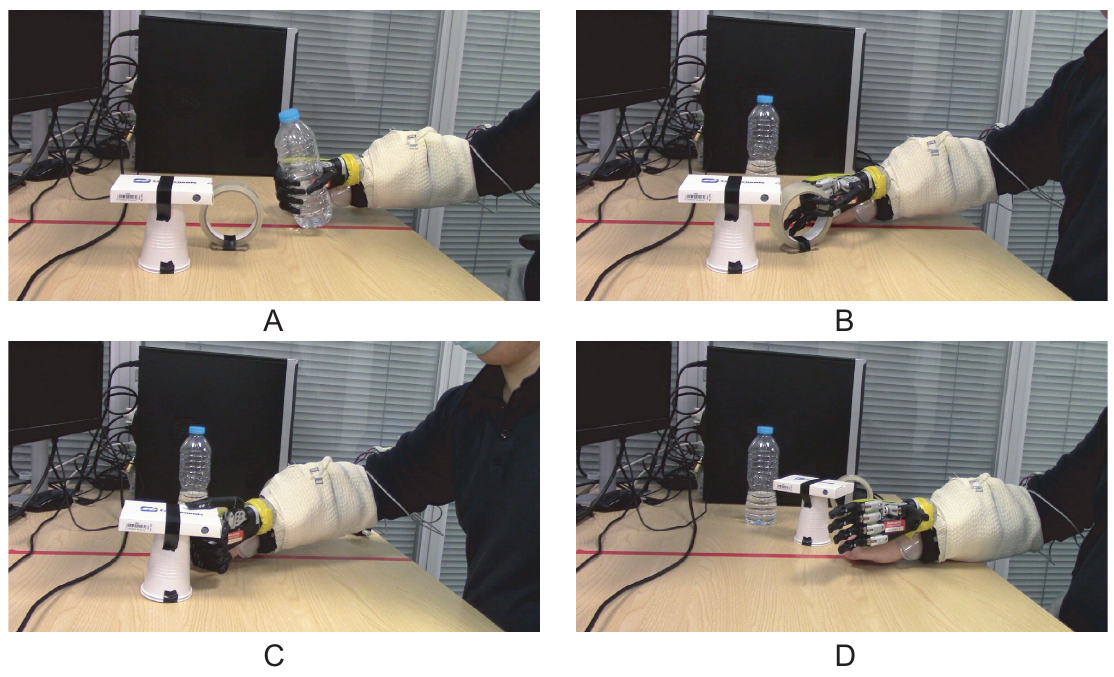
Figure 5. Real-time pick-and-place experiment with three different control algorithms. The participant ( A ) lifted the bottle with a power grip, ( B ) lifted the roll of tape with a tripod grip, ( C ) lifted the credit card simulator with a lateral grip, and ( D ) opened the prosthetic hand to relocate the objects.